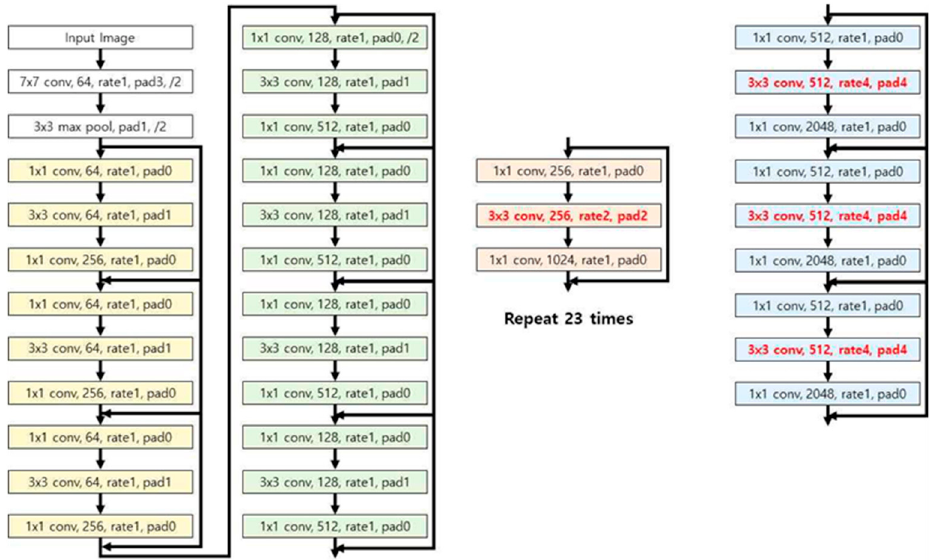
Figure 7. Structure of the modified dilated residual network applied in this study.